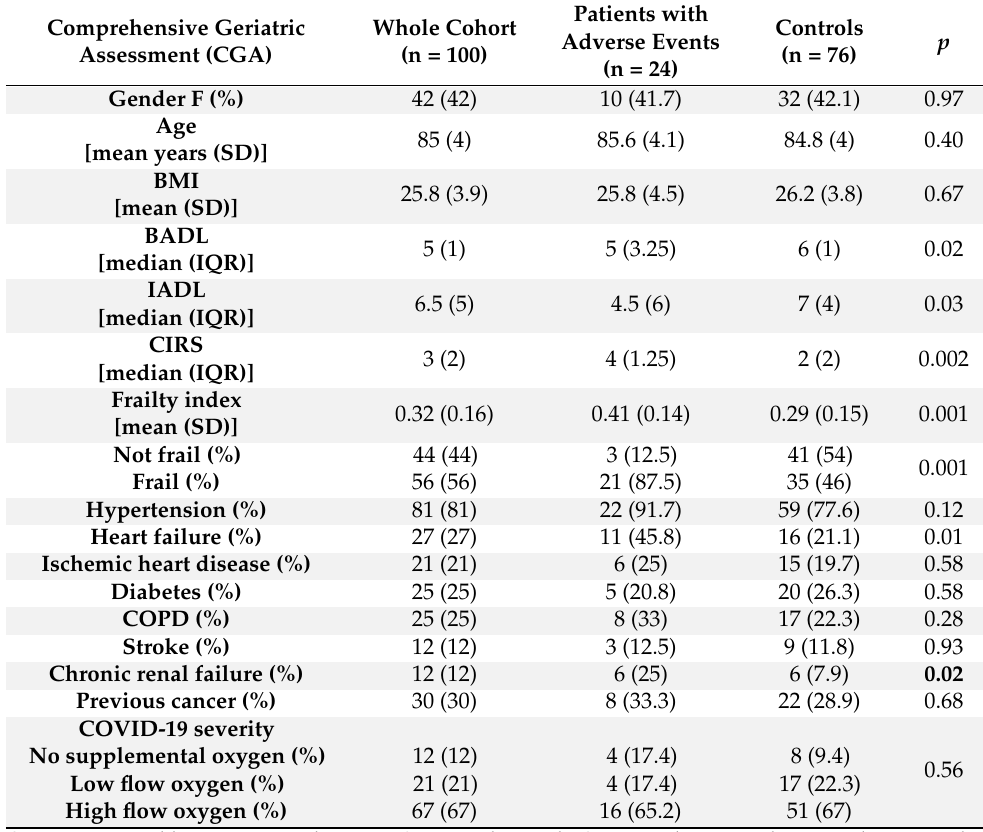
Table 1. Comprehensive Geriatric Assessment (CGA) at